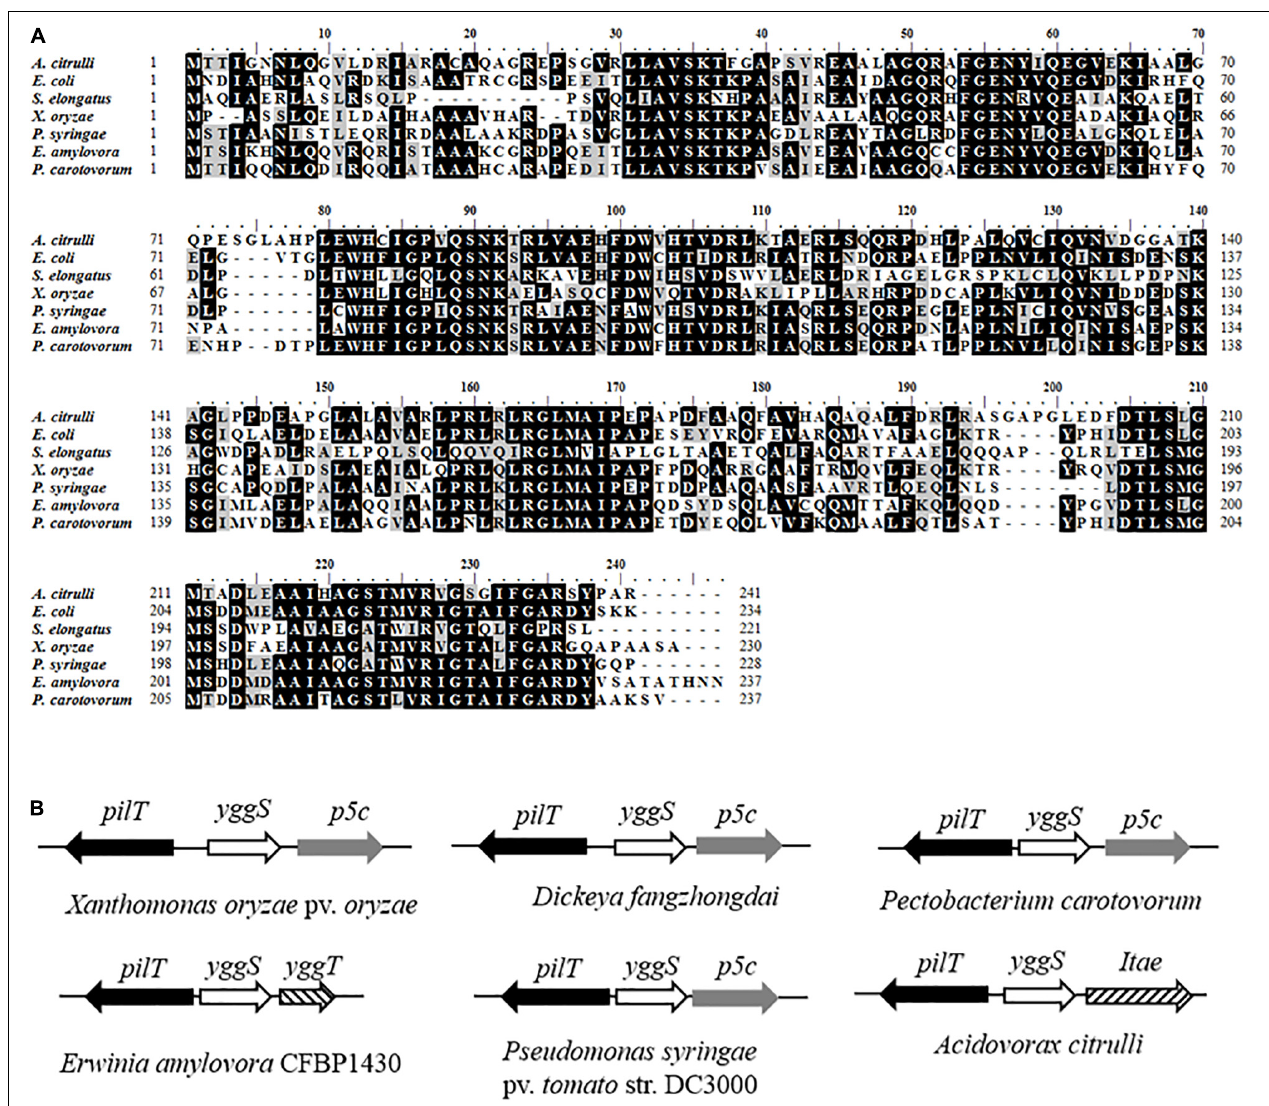
FIGURE 1 | Amino acid sequences of YggS and physical clustering of yggS genes. (A) Multiple alignments of YggS amino acid sequences for Acidovorax citrulli and other important bacteria including Escherichia coli str. K-12 substr. MG1655, Synechococcus elongates PCC7942, Pseudomonas syringae pv. tomato str. DC3000, Xanthomonas oryzae pv. oryzae PXO99A, Dickeya fangzhongdai strain DSM 101947, Erwinia amylovora CFBP1430 and Pectobacterium carotovorum PC1. The analysis was performed by BioEdite V7.0.5. Among these sequences, amino acids marked with black are conserved, and marked with gray are highly homologous. (B) Physical clustering of yggS genes in phytopathogenic bacteria. The direction of the arrow is consistent with the direction of the gene transcription.